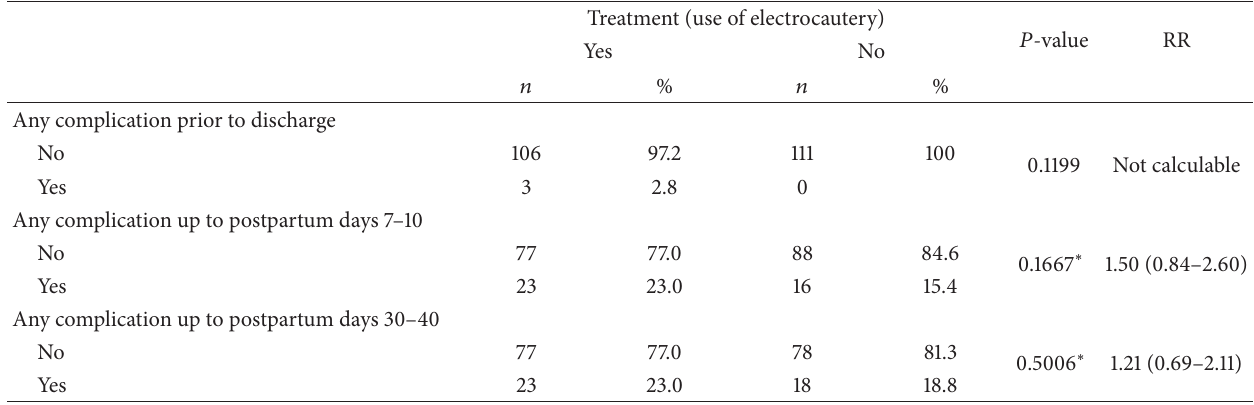
Table 5: Accumulated surgical scar complications ∗ assessed during follow-up, according to the use of electrocautery for hemostasis.